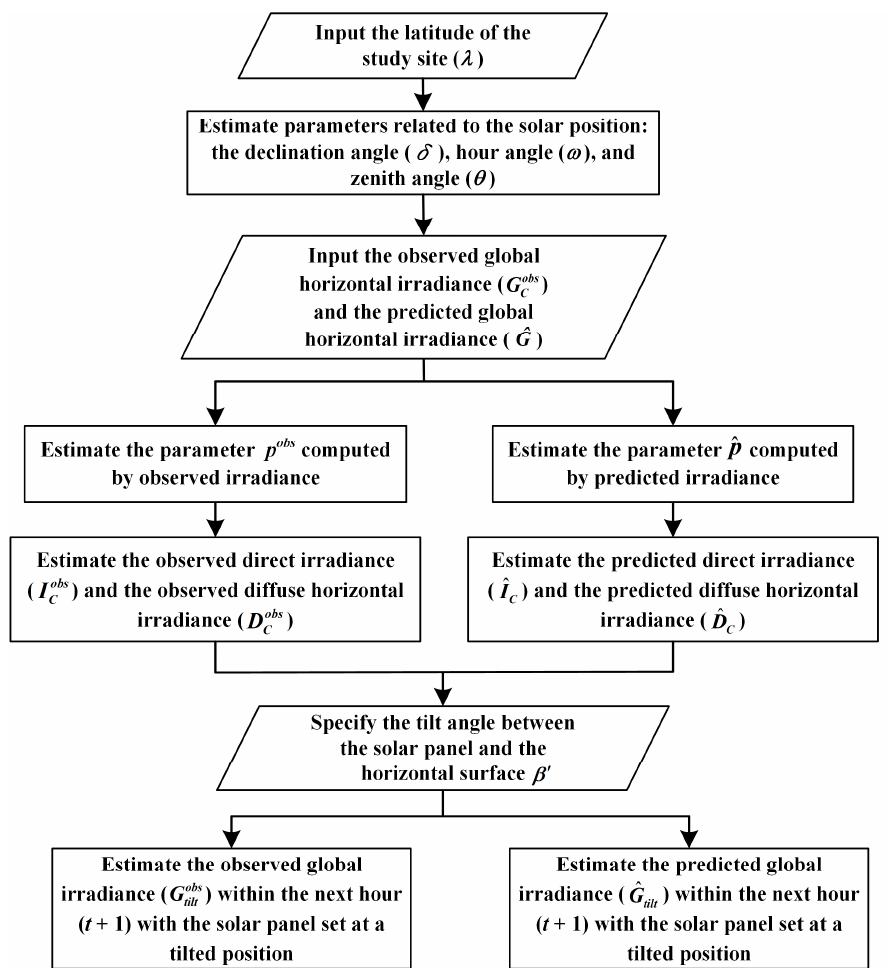
Figure 3. Flowchart of estimating observed and predicted solar irradiance with tilted solar panels.